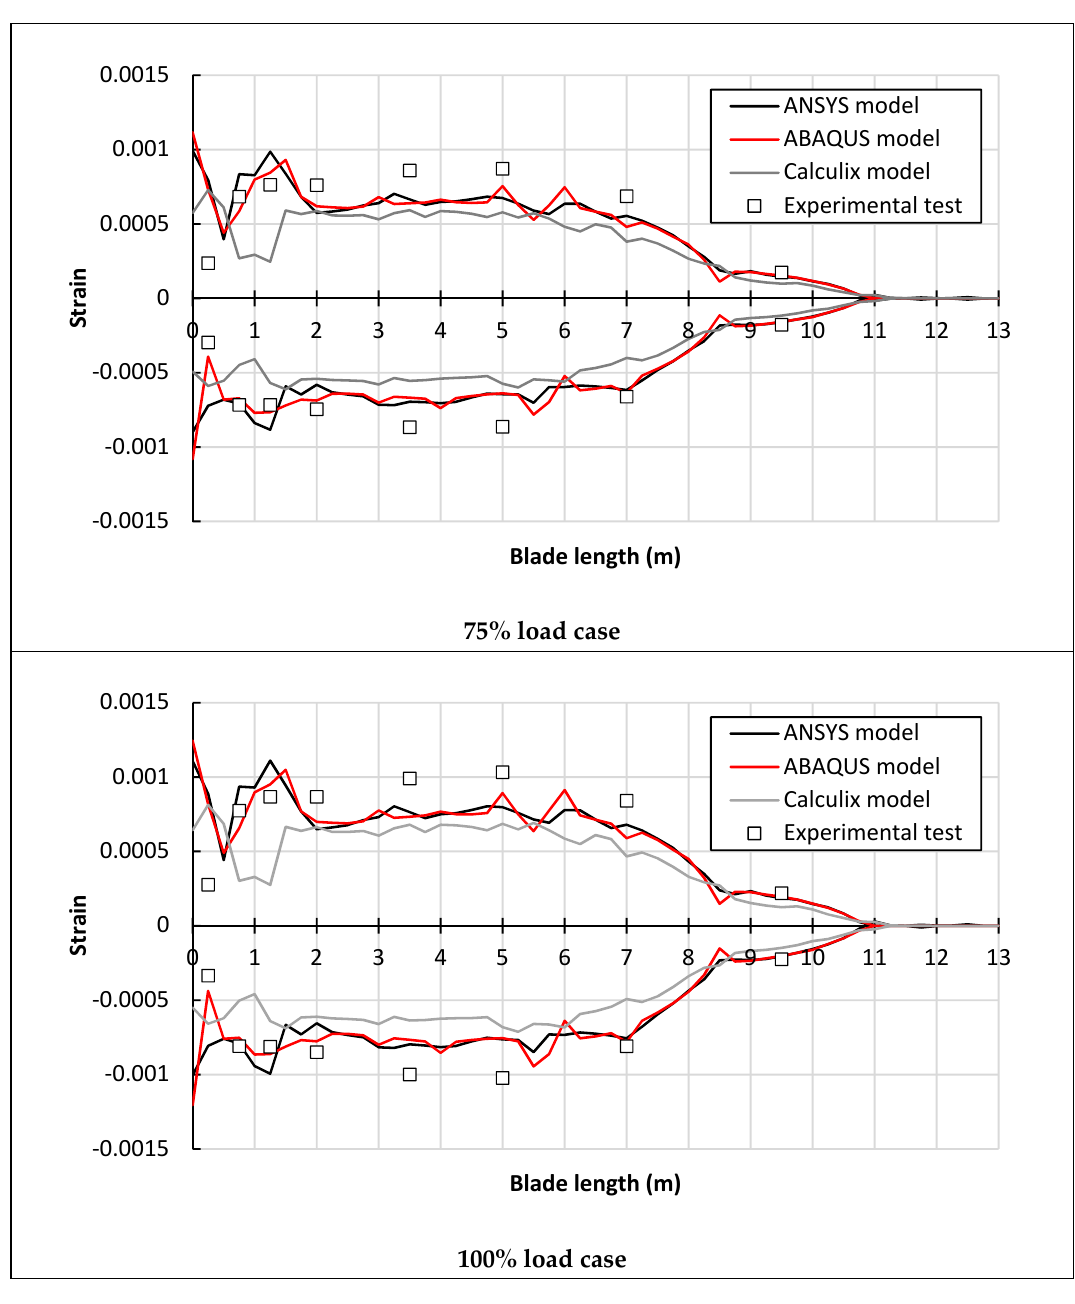
Figure 11. Comparison between the results from the 3 numerical models (ABAQUS, ANSYS, and CalculiX) and the results from the experimental static test showing the strain at the center of the spar caps (showing the pressure side (positive strain) and suction side (negative strain)) on the outer surface along the blade length for each of the load cases in the flapwise direction.